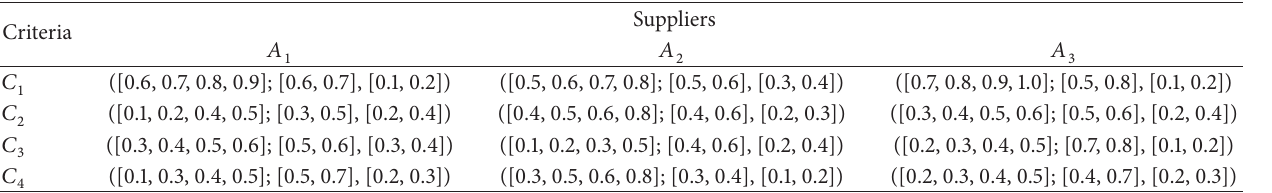
Table 2: Assessment by DM 2